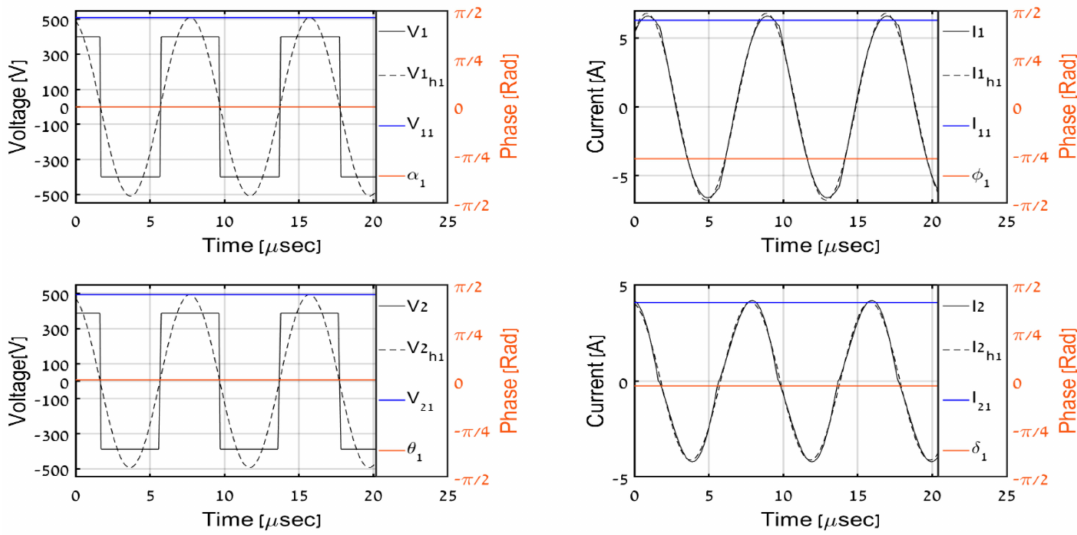
Figure 9. Simulation results, P O = 1000 W.